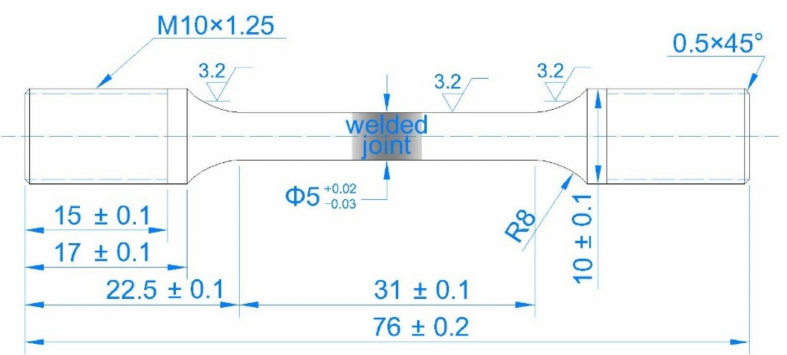
Figure 3. Welding specimen used for slow strain rate testing (units in mm).